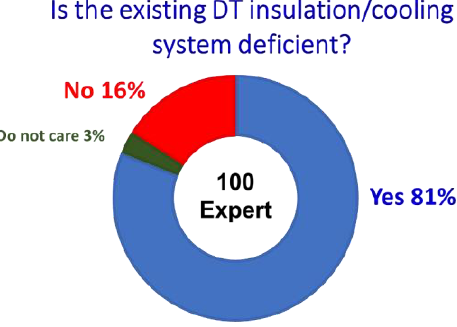
Figure 4. Results of the electronic survey.